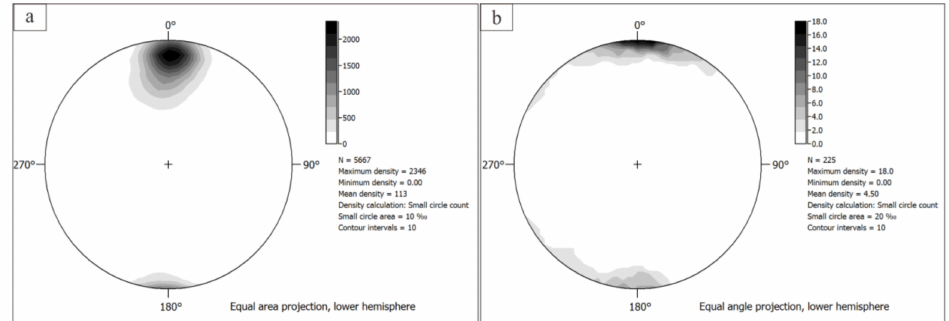
Figure 4. An equal-area upper-hemisphere projection plots the dip direction and angle of quartz veins ( a ) and joints ( b ) in